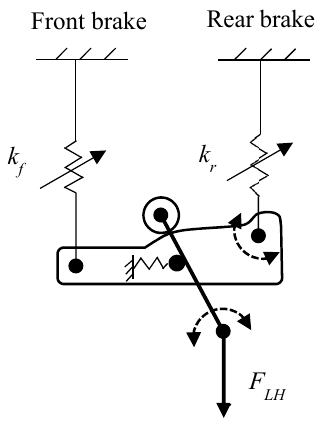
Figure 1. The concept of the variable combined system (VCBS).